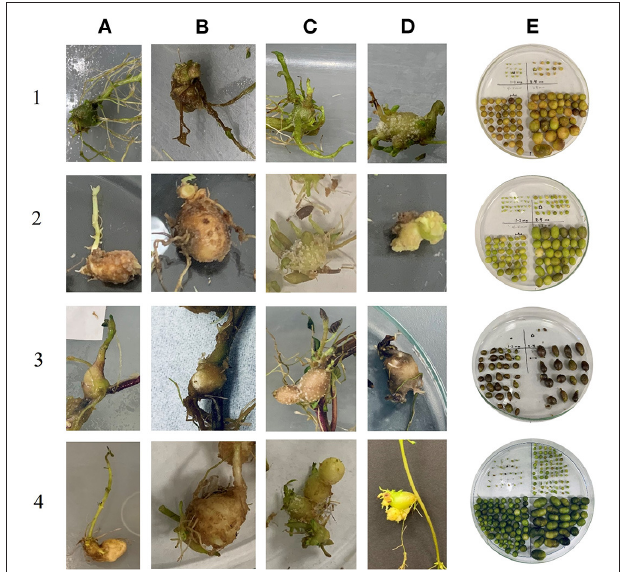
FIGURE 3 | Phenotypes of deformed microtubers and non-deformed microtubers. Horizontal panels (1–4) represent the clones: (1) Atlantic, (2) NDTX081648CB-13W, (3) Reveille Russet, and (4) Russet Burbank. Vertical panels (A–D) represent the categories of deformed microtubers at 30 ◦ C and (E) represents non-deformed microtubers produced at 16 ◦ C. (A) Deformed microtuber with sprouts, (B) Deformed microtuber with roots, (C) Deformed microtuber with excessive outgrowths, (D) Deformed microtuber with unusual